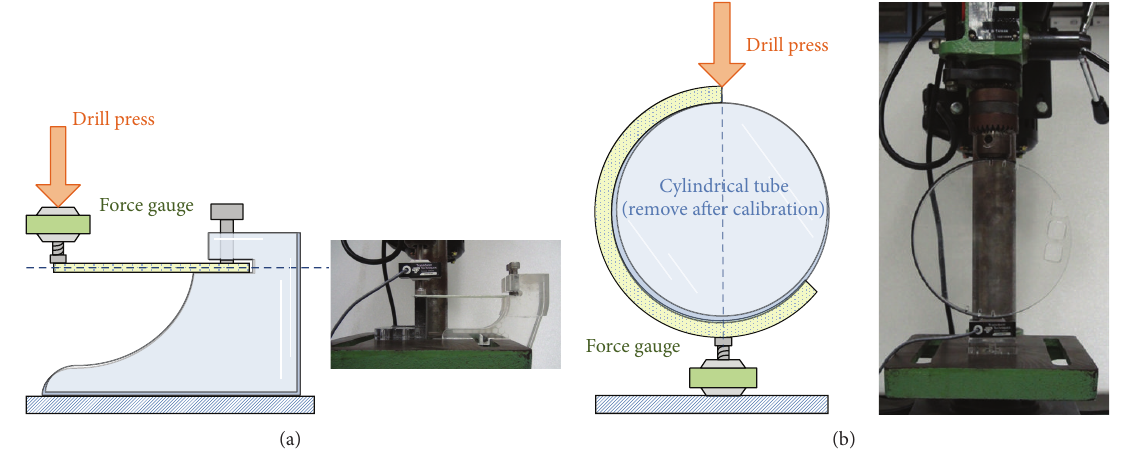
Figure 7: Measurement setup of the cantilever beam experiments (a) and the curved beam experiments (b).